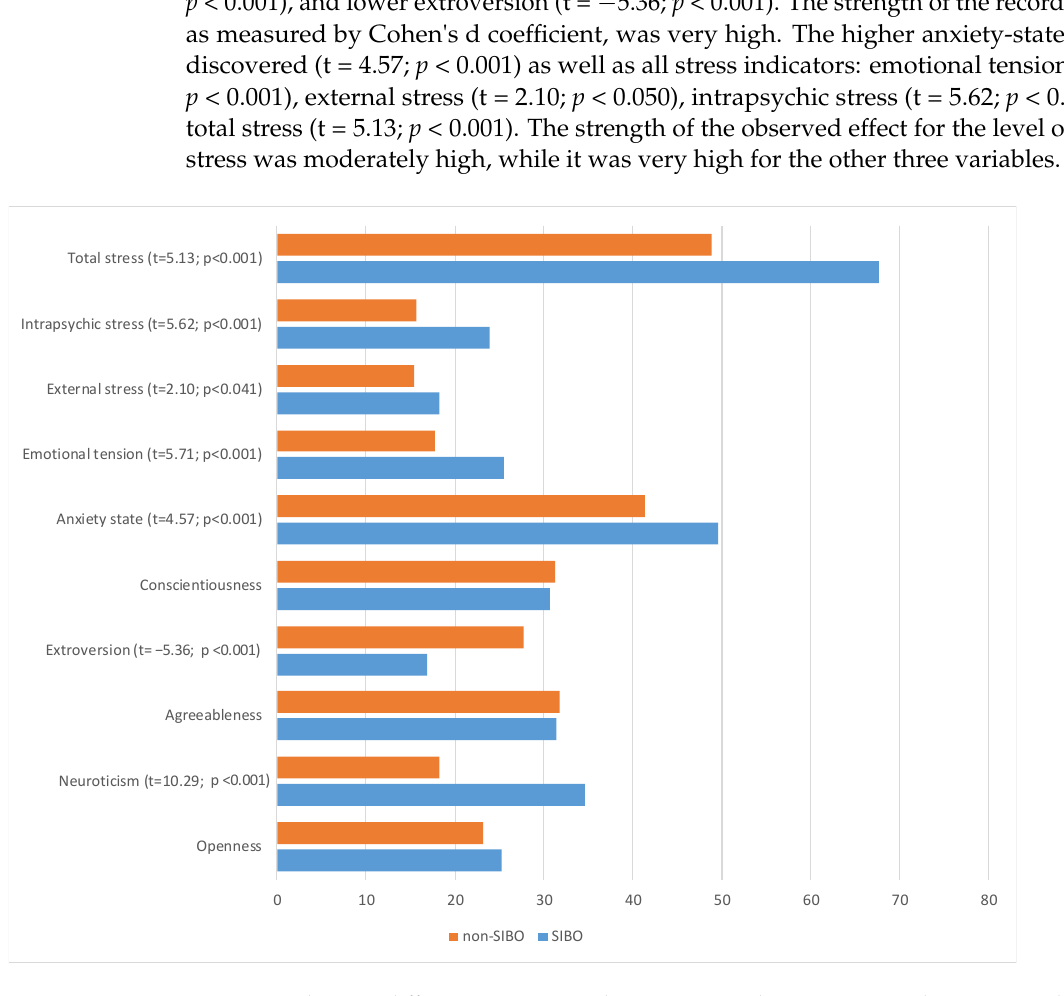
Anxiety state. The relationships between stress and personality traits in the SIBO context are presented in Table